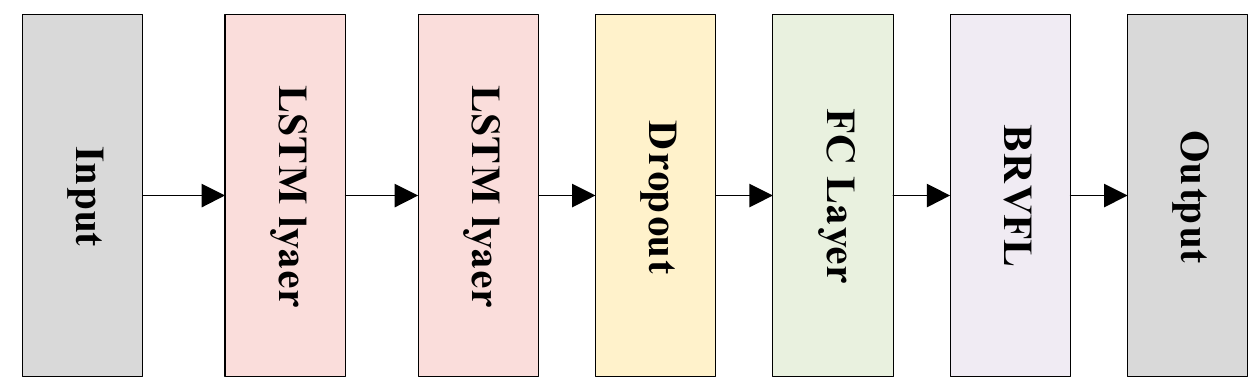
stability. The model structure of ILSTM-BRVFL (without IAOS) is shown in Figure 5. The pseudocode of ILSTM-BRVFL is shown in Algorithm 4. The flowchart of oil layer prediction is shown in Figure 6.